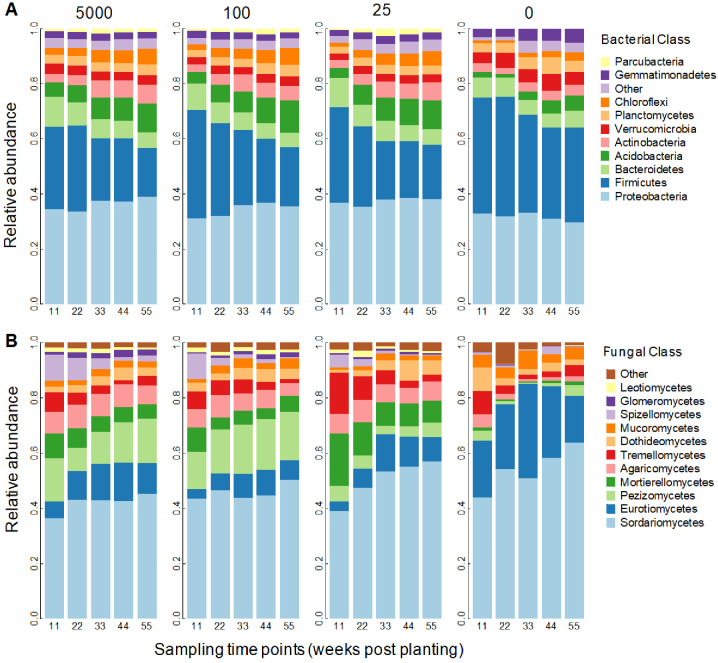
Proportional abundance of (A) fungal classes and (B) bacterial classes is shown for each time point (11, 22, 33, 44, and 55 weeks) and for the different inoculum treatments created by sieving soil through 5000, 100, 25 µm, and sterile, corresponding to 0 µm (shown in subpanels from left to right).